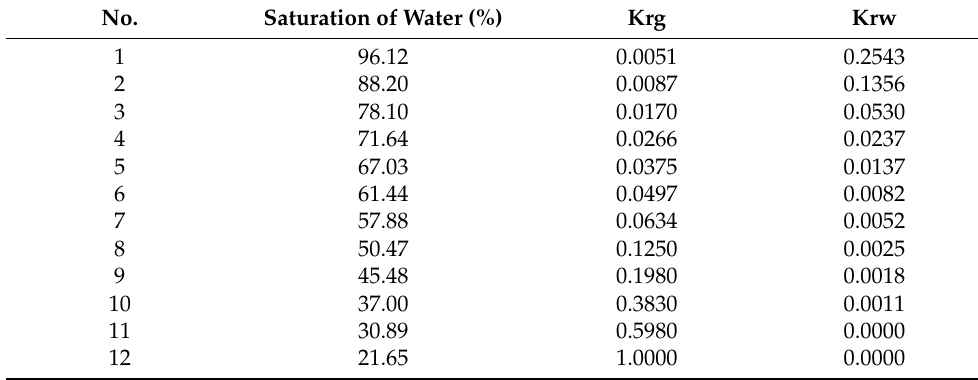
Table A8. The relative permeabilities of No.4 sandstone